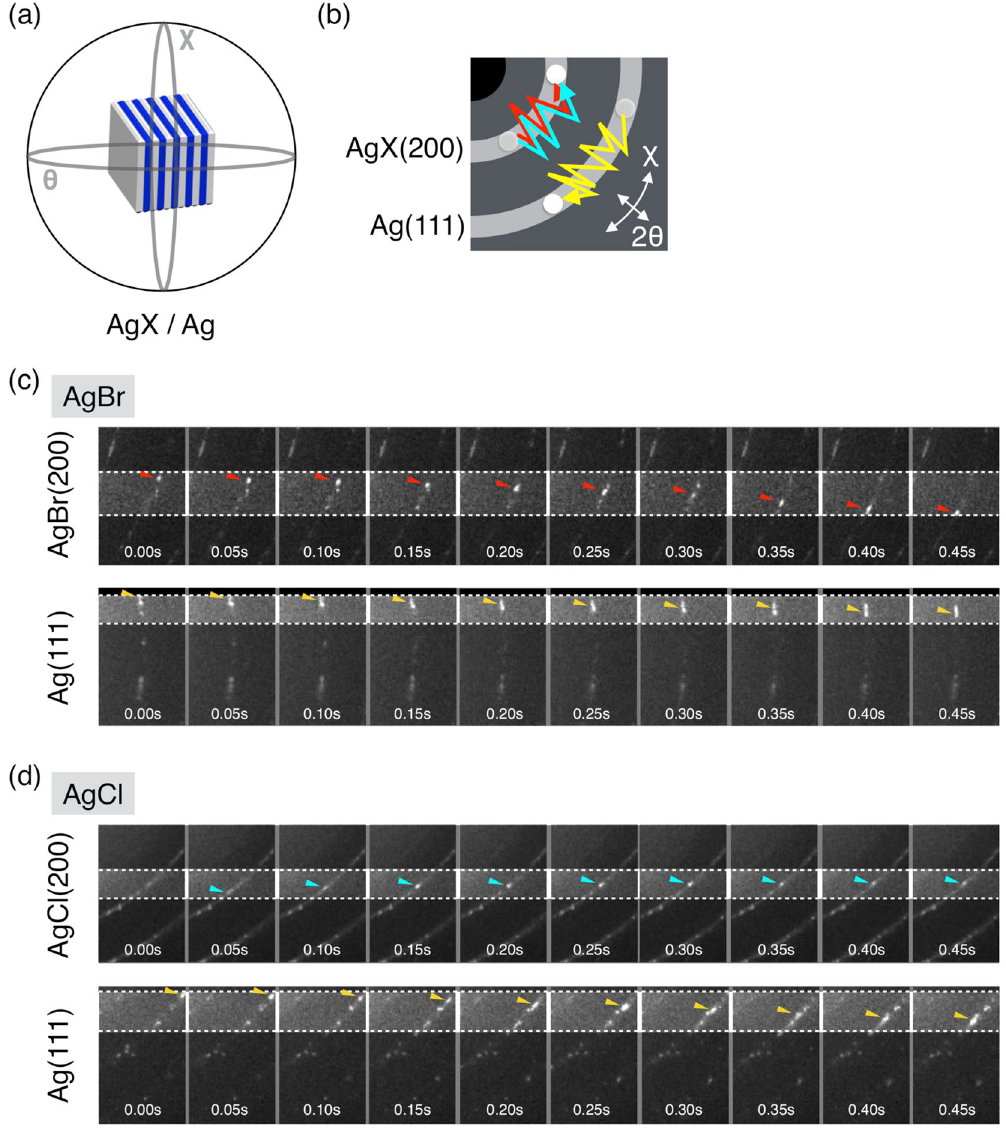
Figure 3. Movements of the diffraction spots in silver halide AgX(200) and silver Ag(111). ( a ) Schematic illustration of the detection of internal motions of silver halides and silver by DXB. ( b ) Schematic illustration of the diffraction spot movement in AgX(200) and Ag(111). ( c , d ) Movement of the diffraction spots on AgX(200) and Ag(111) in AgBr and AgCl,